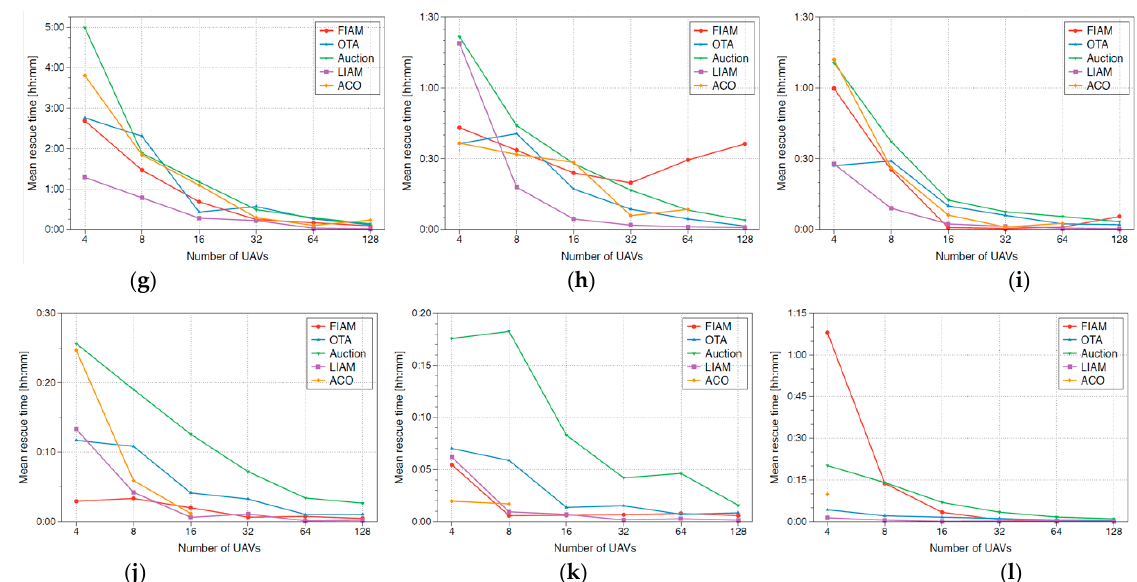
Figure 6. Mean rescue time as the number of survivors increases from 2 to 4096. ( a ) Mean rescue time for 2 survivors. ( b ) Mean rescue time for 4 survivors. ( c ) Mean rescue time for 8 survivors. ( d ) Mean rescue time for 16 survivors. ( e ) Mean rescue time for 32 survivors. ( f ) Mean rescue time for 64 survivors. ( g ) Mean rescue time for 128 survivors. ( h ) Mean rescue time for 256 survivors. ( i ) Mean rescue time for 512 survivors. ( j ) Mean rescue time for 1024 survivors. ( k ) Mean rescue time for 2048 survivors. ( l ) Mean rescue time for 4096 survivors. UAV, Unmanned Ariel Vehicle; FIAM, fish-inspired algorithm for task allocation in multi-UAV missions; OTA, opportunistic task allocation; ACO, ant colony optimization; LIAM, locust-inspired algorithm for MUTA problem.